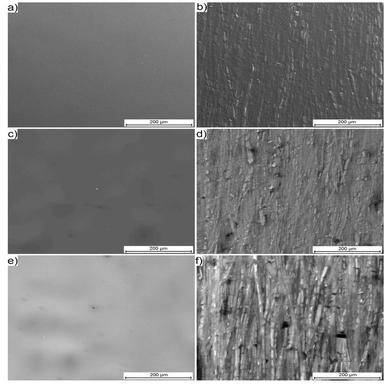
SEM microphotographs of a) Ref_g, b) Ref_m, c) TEOS_am_g, d) TEOS_am_m, e) TEOS_BTSE_am_g and f) TEOS_BTSE_am_m samples.